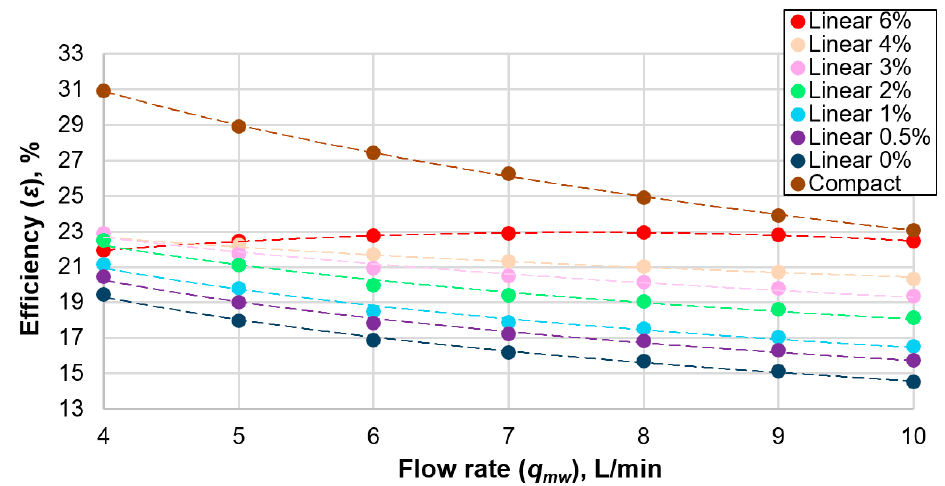
Figure 7. Efficiency of the shower heat exchangers determined for T cw = 14 °C.